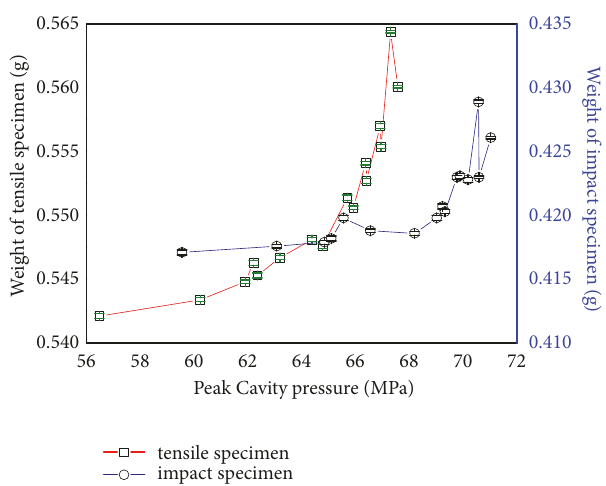
Figure 8: Effect of the peak cavity pressure on the tensile and impact specimen